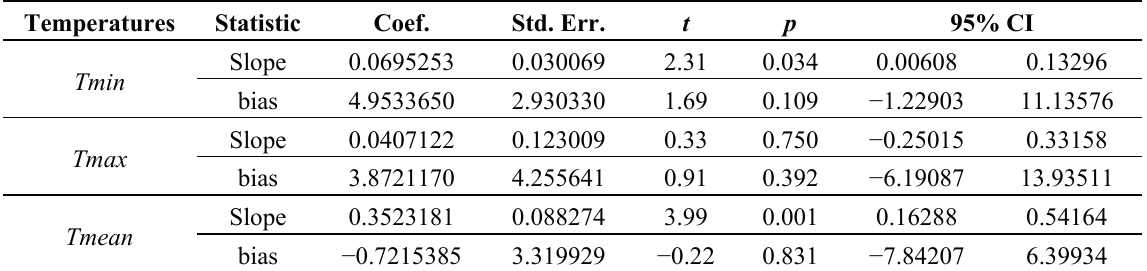
Table 4. Egger’s test for publication